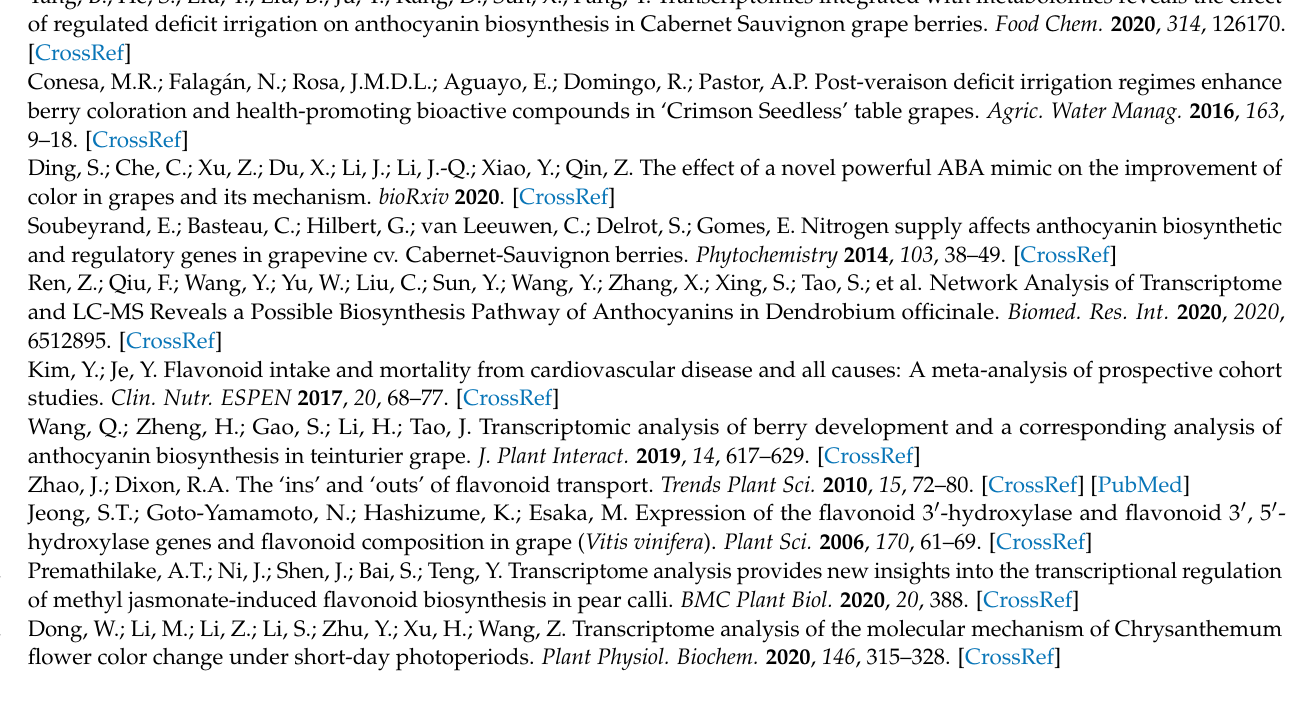
at 90 DAFB. Table S2: Candidate structural genes related to flavonoid biosynthesis at 110